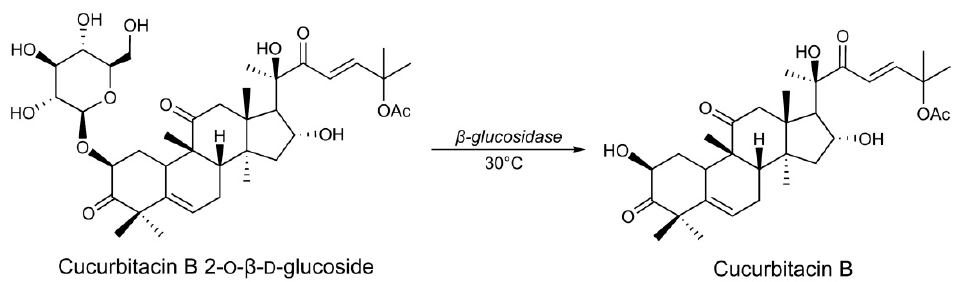
Figure 1. Biotransformation of CuBg to CuB by β -glucosidase.